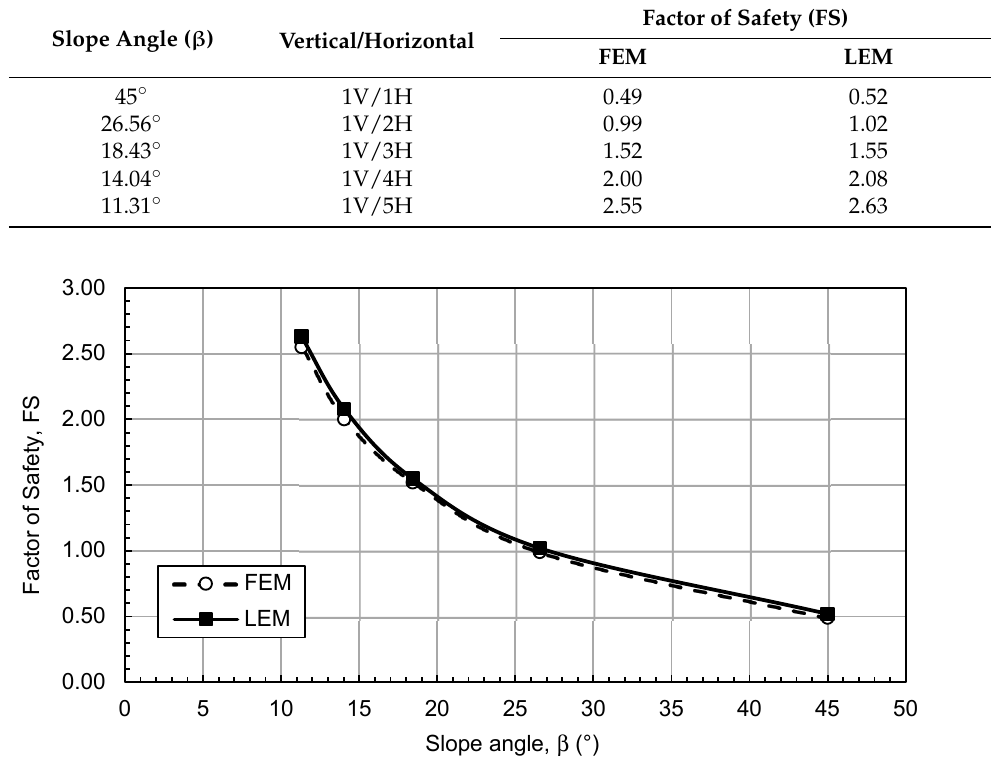
Figure 7. Variation in FS with β .